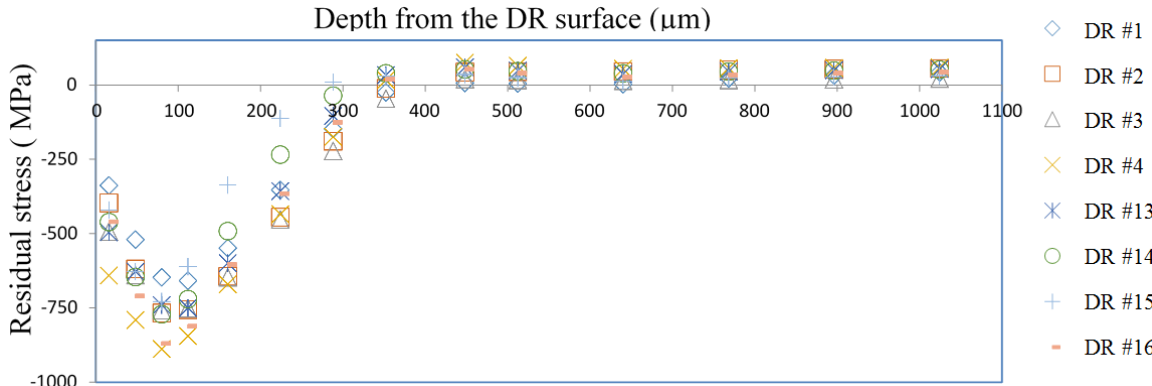
Figure 9. Residual stress distribution DR-treated Ti64 with 100 bar (low pressure).